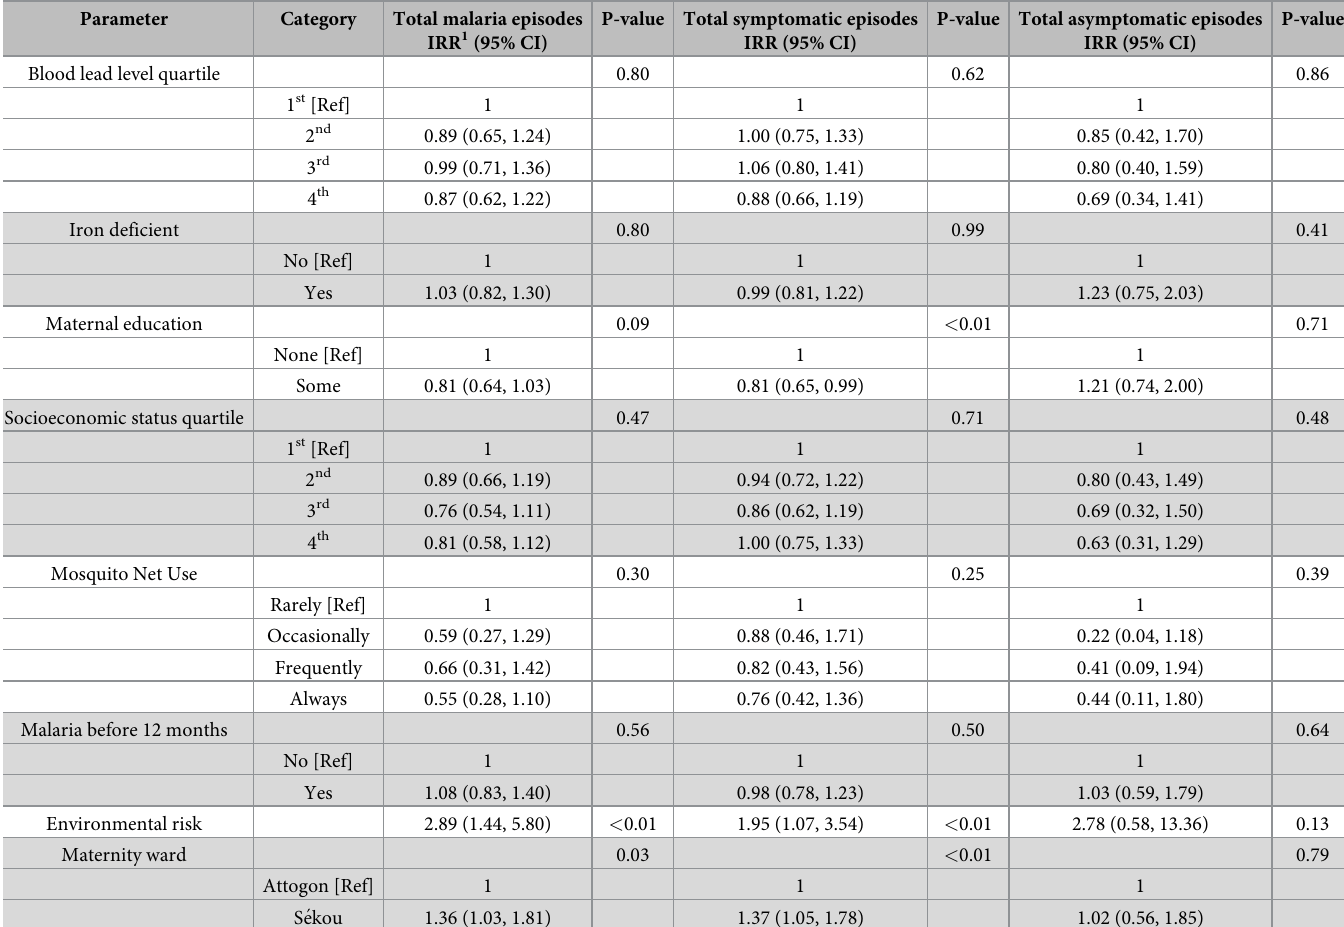
Table 2. Univariate negative binomial regression between potential confounders and malaria outcomes †